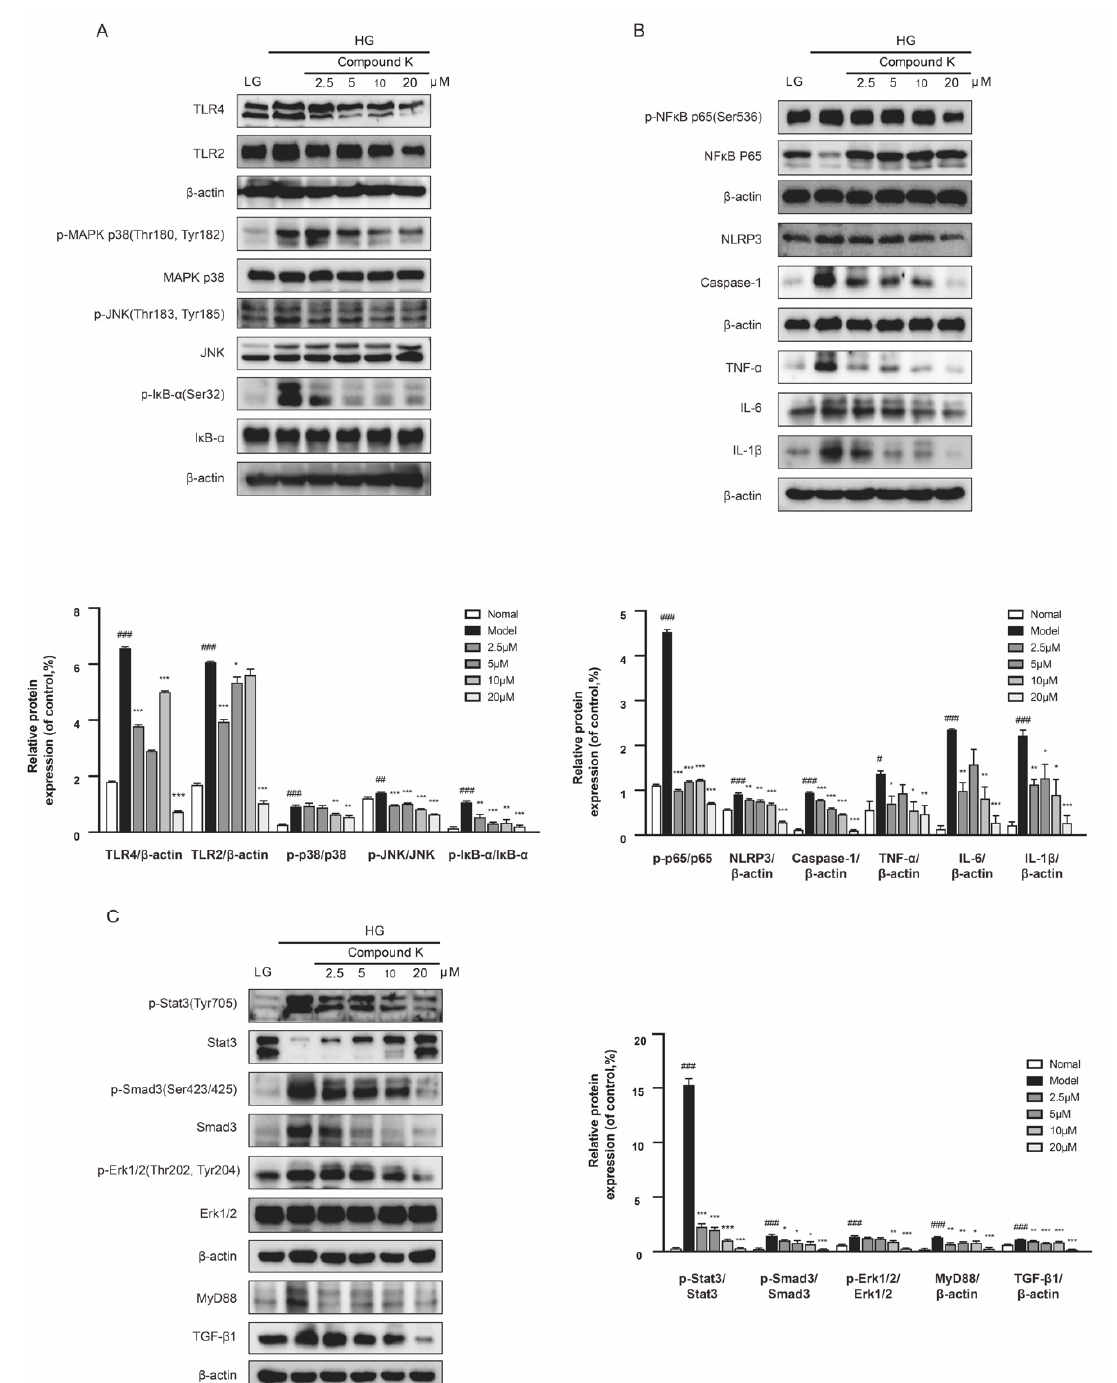
Figure 5 . CK suppresses TLR4 signaling pathway in the presence of high glucose concentration. ( A ) The protein expression of TLR4, TLR2 and phosphorylated and total MAPK p38, JNK, and I κ B- α were detected in mesangial cells. ( B ) The protein expression of phosphorylated and total NF- κ B, and NLRP3, caspase 1, TNF- α , IL-6, and IL-1 β were detected in mesangial cells. ( C ) The protein expression of phosphorylated and total Stat3, Smad3, and Erk1/2; the protein expression of MyD88 and TGF- β 1 were detected. Data were expressed as means ± SEM ( n = 3). LG, low glucose medium; HG, high glucose medium. ### p < 0.001, ## p < 0.01, # p < 0.05 compared to normal. *** p < 0.001, ** p < 0.01, * p < 0.05 compared to model.